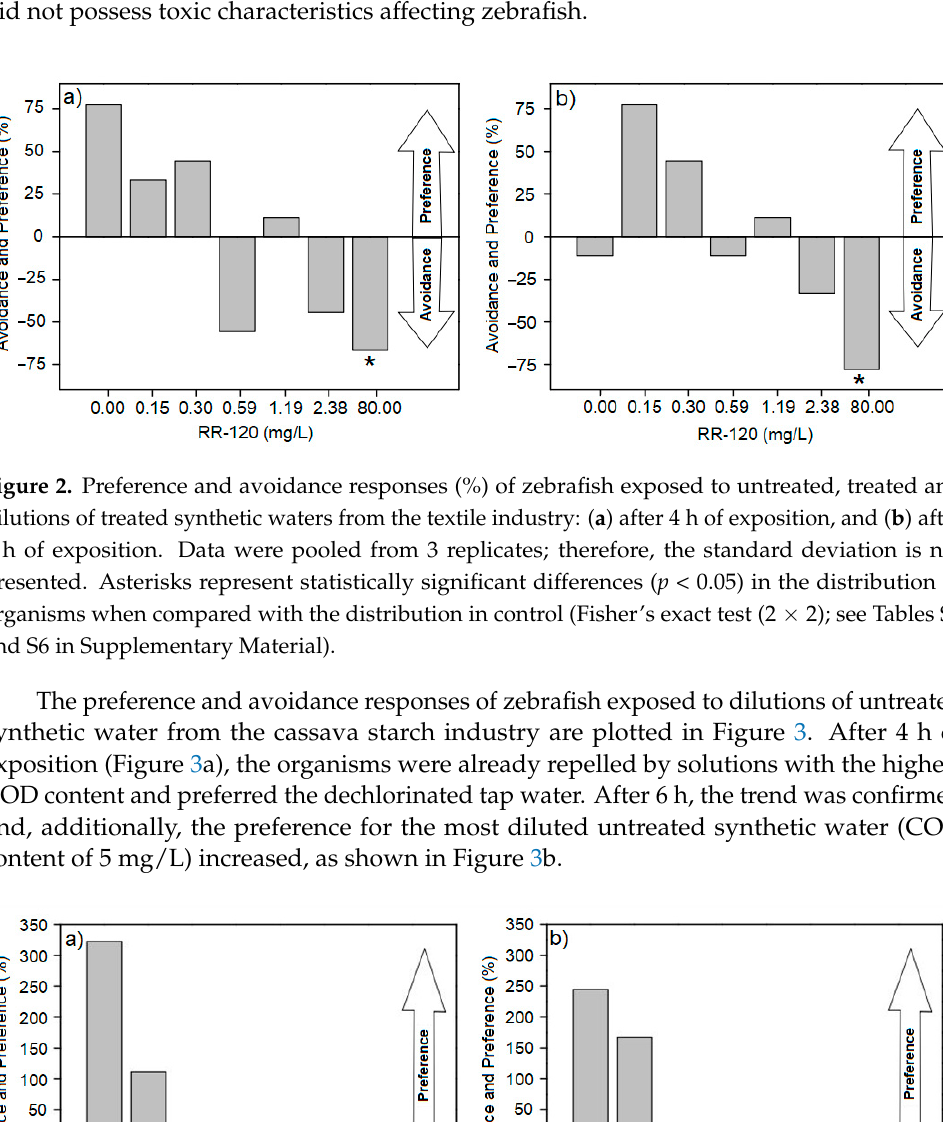
Figure 4. Preference and avoidance responses (%) of zebrafish exposed to treated synthetic water from the cassava starch industry: ( a ) after 4 h of exposition, and ( b ) after 6 h of exposition. Data were pooled from 3 replicates; therefore, the standard deviation is not presented. Asterisks represent sta- tistically significant differences ( p < 0.05) in the distribution of organisms when compared with the distribution in control (Fisher’s exact test (2 × 2); see Tables S9 and S10 in Supplementary Material). Changes in the distribution of organisms per compartment could be related to the content of total cyanide in water. The relation of the distribution of organisms per com- partment and the content of total cyanide for the assays with untreated and treated syn- thetic waters from the cassava starch industry is depicted in the plots of Figure 5. Cer- tainly, the removal of cyanide seems to have a strong influence on the preference of zebrafish.